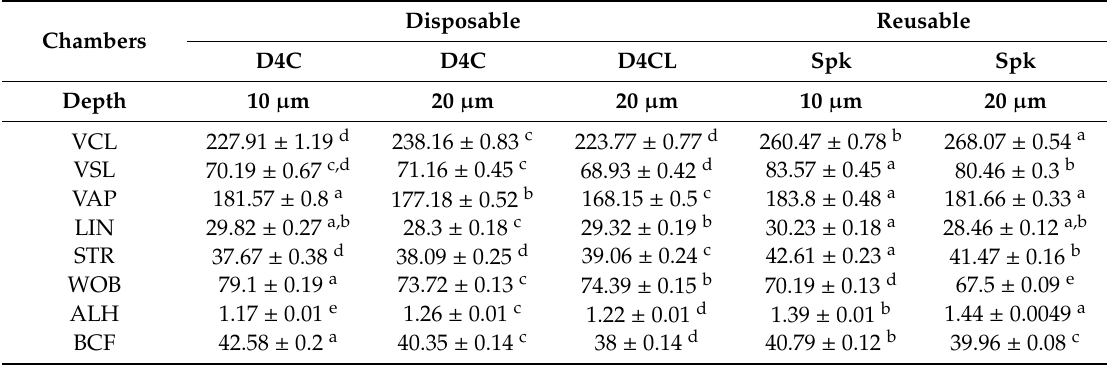
Table 2. Motility parameters (mean ± SEM) of donkey spermatozoa determined by CASA system using disposable and reusable chambers obtained at 250 frames. Chambers